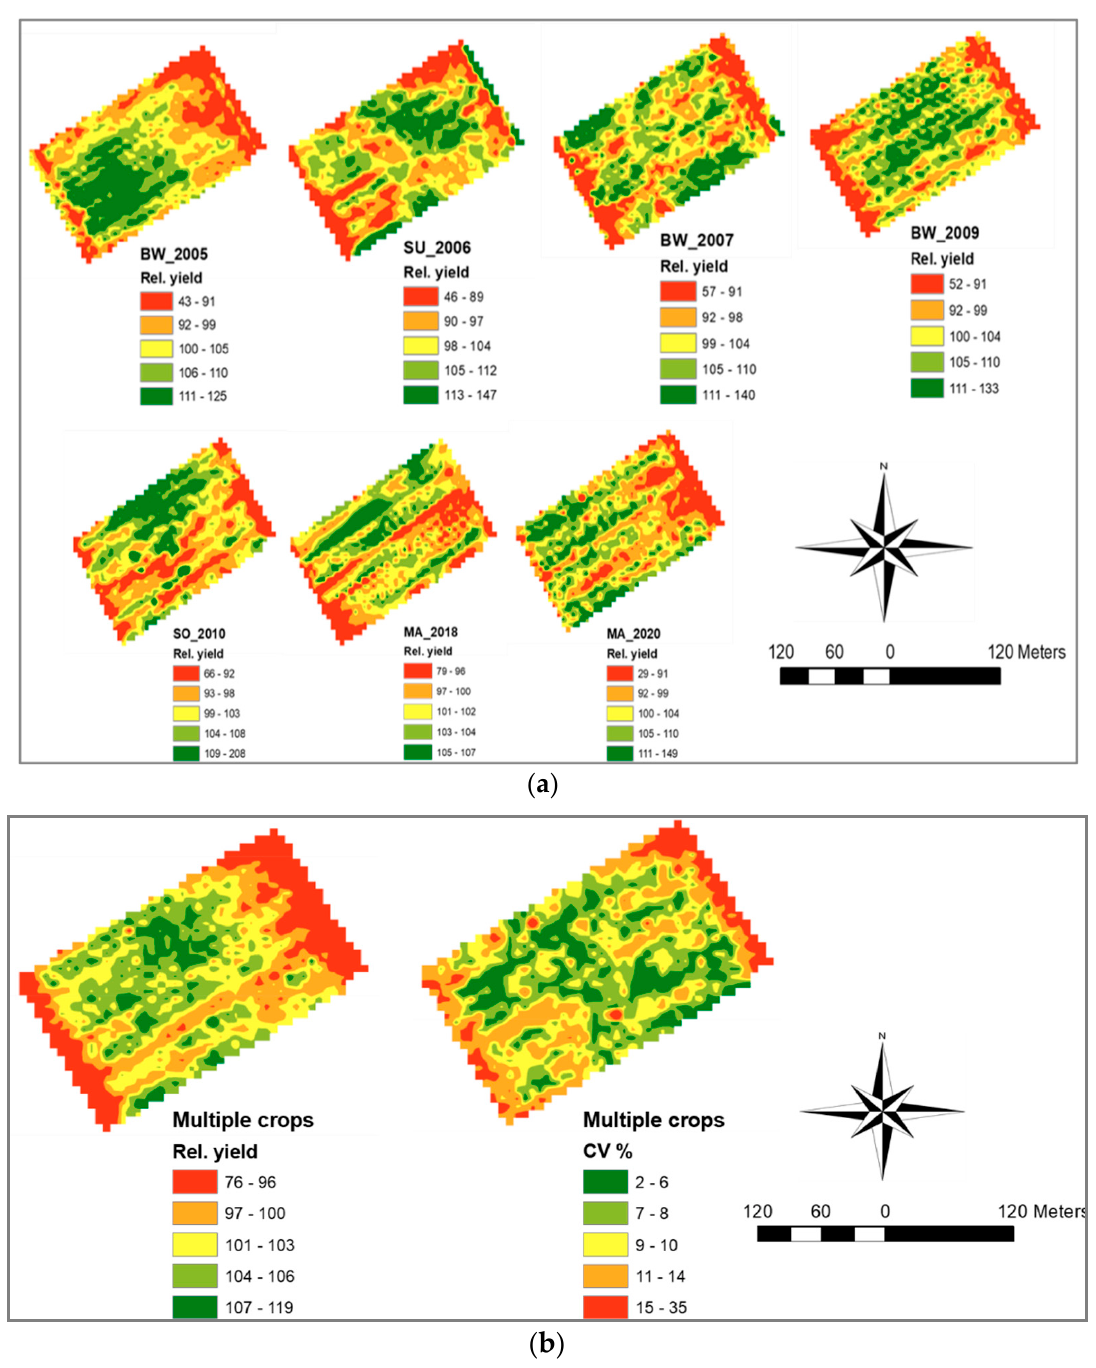
Figure 3. Spatial maps ( n = 937 ) of single crop yields ( a ), and multiple crop yields and the related coefficient of variation (CV) ( b ).